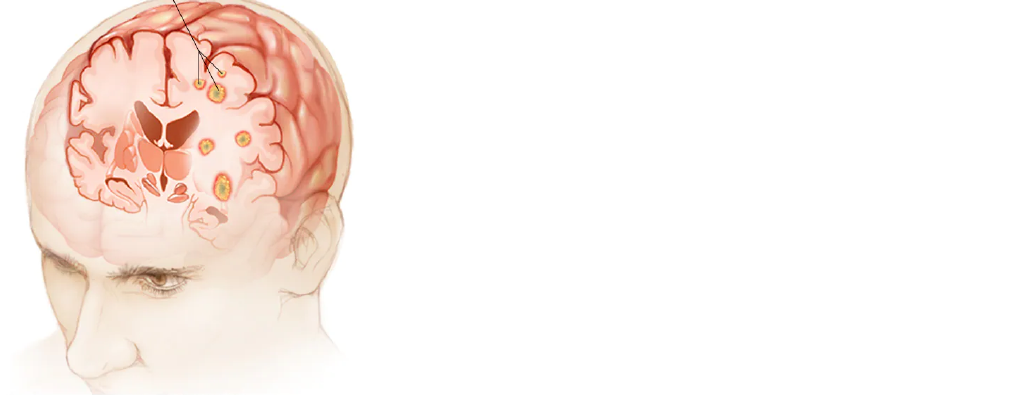
Figure 6. Brain-metastases: brain tumour of type 2 (source: https://www.mayoclinic.org/diseases-